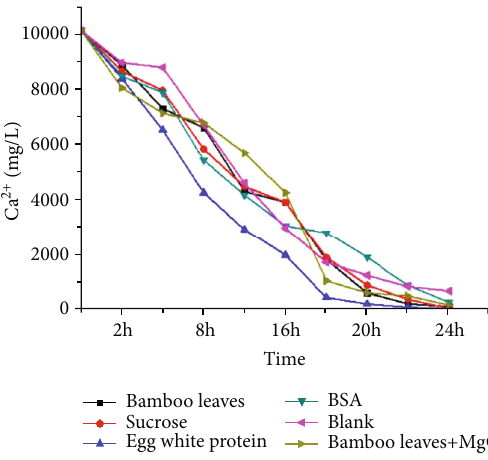
Figure 5: pH change diagram of reaction solution.